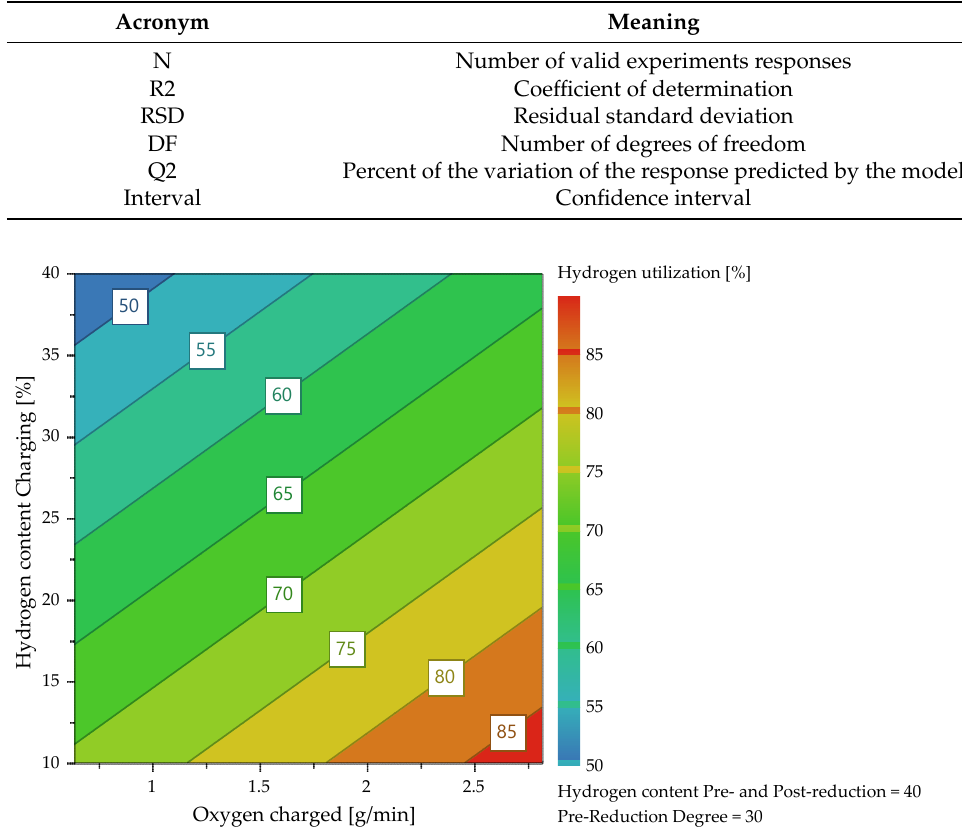
Figure 14. Average hydrogen utilization as a function of the charged oxygen rate.